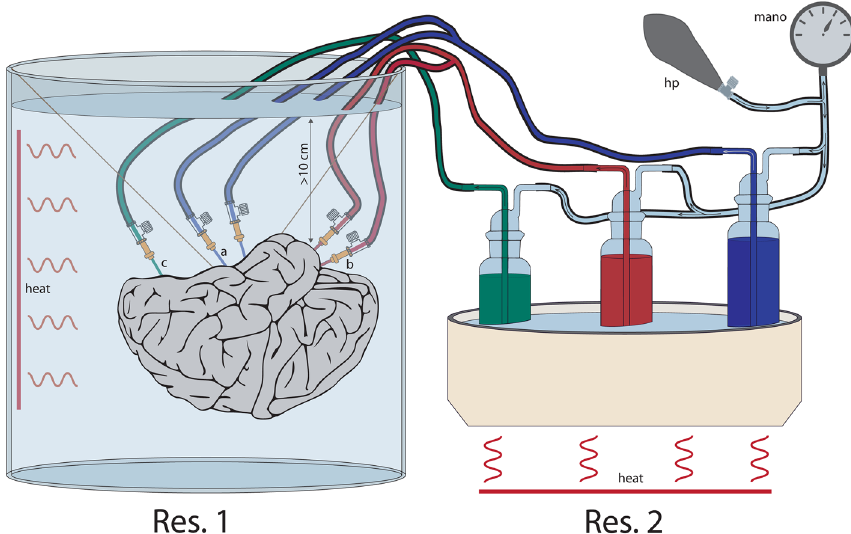
Figure 2. Schematic representation of a simultaneous injection apparatus. It consisted of two reservoirs. The bigger ( Res. 1 ) was a cylindrical glass aquarium accommodating the floating brain. The smaller ( Res. 2 ) was a paraffin mounting bath containing glass gas washing bottles. In both reservoirs, the water temperature was 40 °C to prevent the gelatin solution from early solidification. To maintain the desired water temperature in the left tank, we used a low-temperature cooking machine with a built-in thermostat which simultaneously agitated/ heated the water; the smaller reservoir had a built-in heating element and thermostat. The gas washing bottles were connected with silicon tubes to the catheters on one side (the anterior (a) and middle (b) cerebral arteries through the Y-connectors, the basilar artery (c)—directly) and a hand pump with a manometer on the